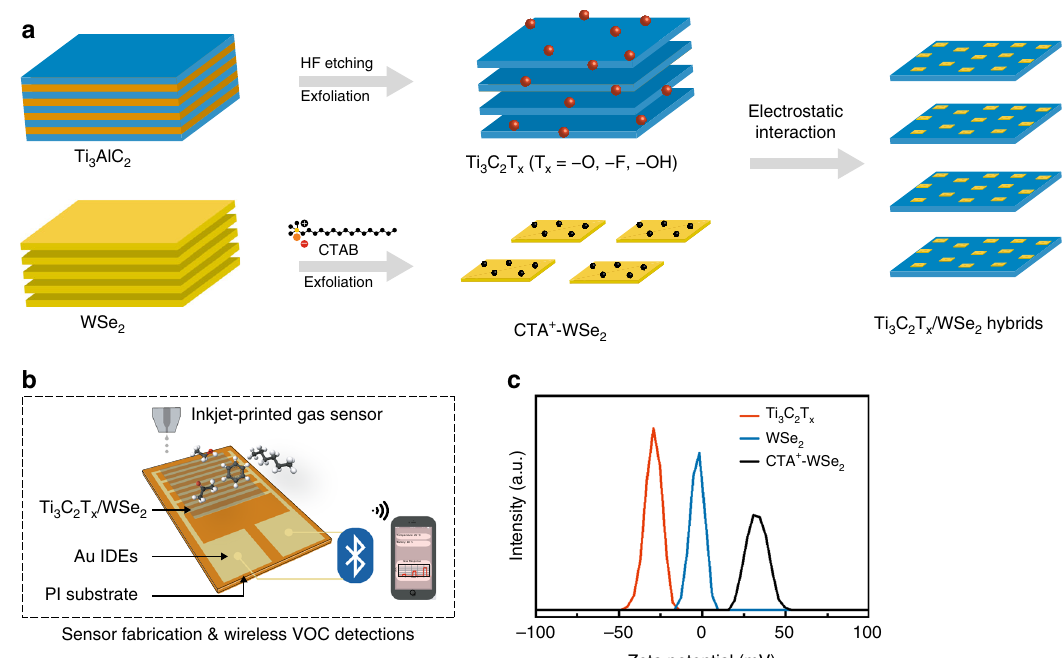
Fig. 1 Ti 3 C 2 T x /WSe 2 hybridization and sensor fabrication. a Schematic illustration of preparation processes for Ti 3 C 2 T x /WSe 2 nanohybrids. b Schematic illustration of inkjet-printed gas sensors in detection of volatile organic compounds with a wireless monitoring system. c Zeta potential distributions of Ti 3 C 2 T x , WSe 2 , and CTA + -WSe 2